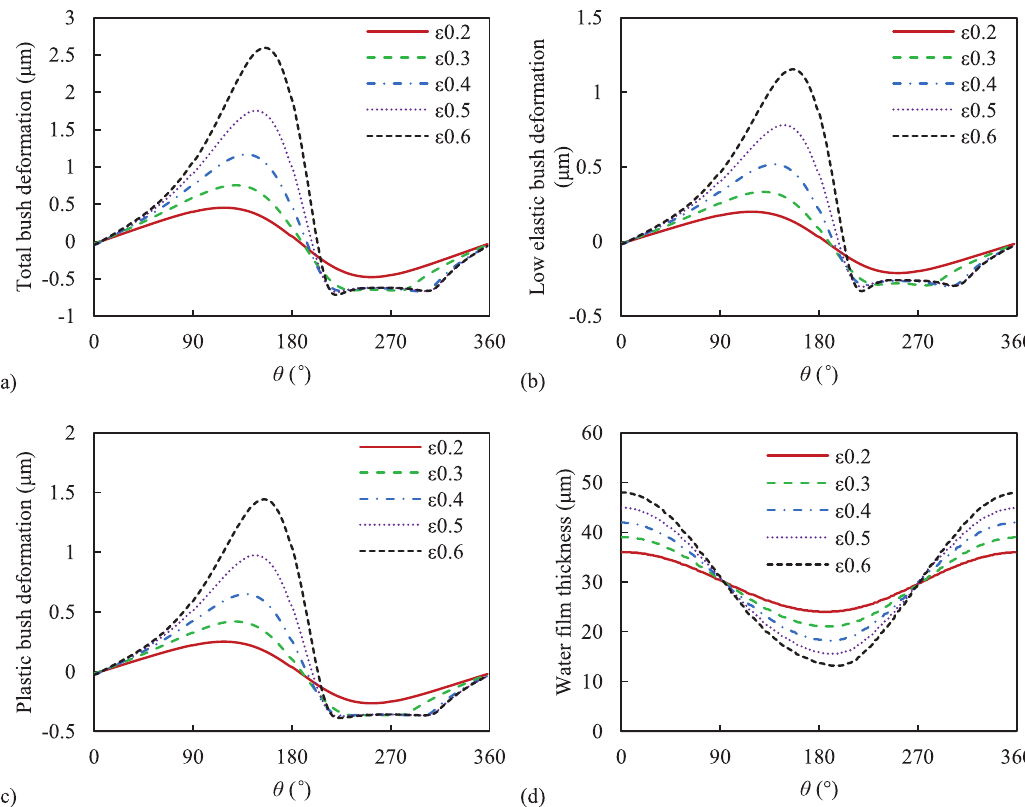
Fig. 8. (a) Bush total deformation distribution, (b) Deformation distribution of low elastic bush, (c) Deformation distribution of plastic layer bush, (d) Water fi lm thickness distribution for different eccentricity ratio ( N =1500 rpm, t 1 = t 2 = 5mm, E 1 =1000 MPa, E 2 = 400MPa, n 1 =0.4, n 2